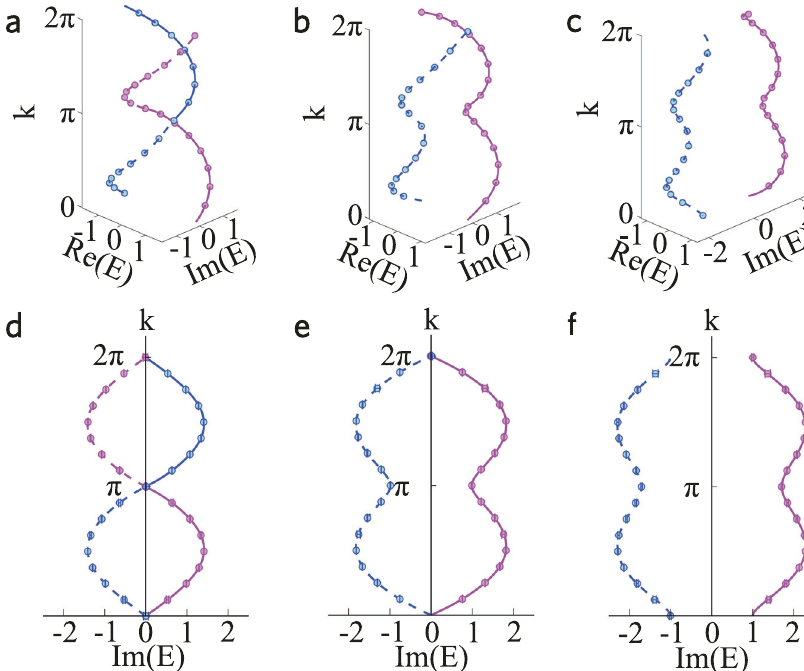
Fig. 6 Non-Hermitian band structures of the twister Hamiltonian. Parameters: a , m 1 = 0.5338, m 2 = 0.6 (the Hopf link phase); b , m 1 = 1.2730, = 0.6 (the unknot phase); and c , m = 1.8889, m = 0.6 (the unlink phase). a – c , Braiding patterns of the complex eigenenergy bands. m 2 1 2 d – f , Projection of the 3D complex eigenenergy bands onto the 2D ( Im ð E Þ ; k ) plane. The purple and blue curves denote the theoretical predictions of the two eigenenergy strings. The solid (dashed) curves denote the non-Hermitian bands with positive (negative) imaginary part of eigenenergy. The corresponding experimental results are represented by the purple and blue dots with error